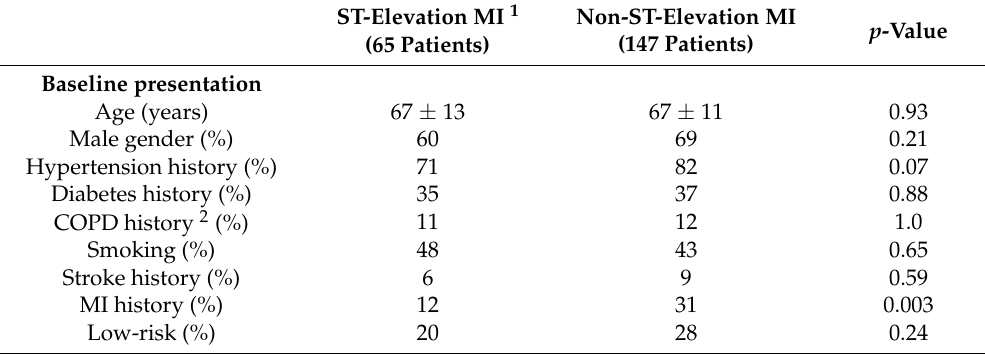
ST-Elevation MI